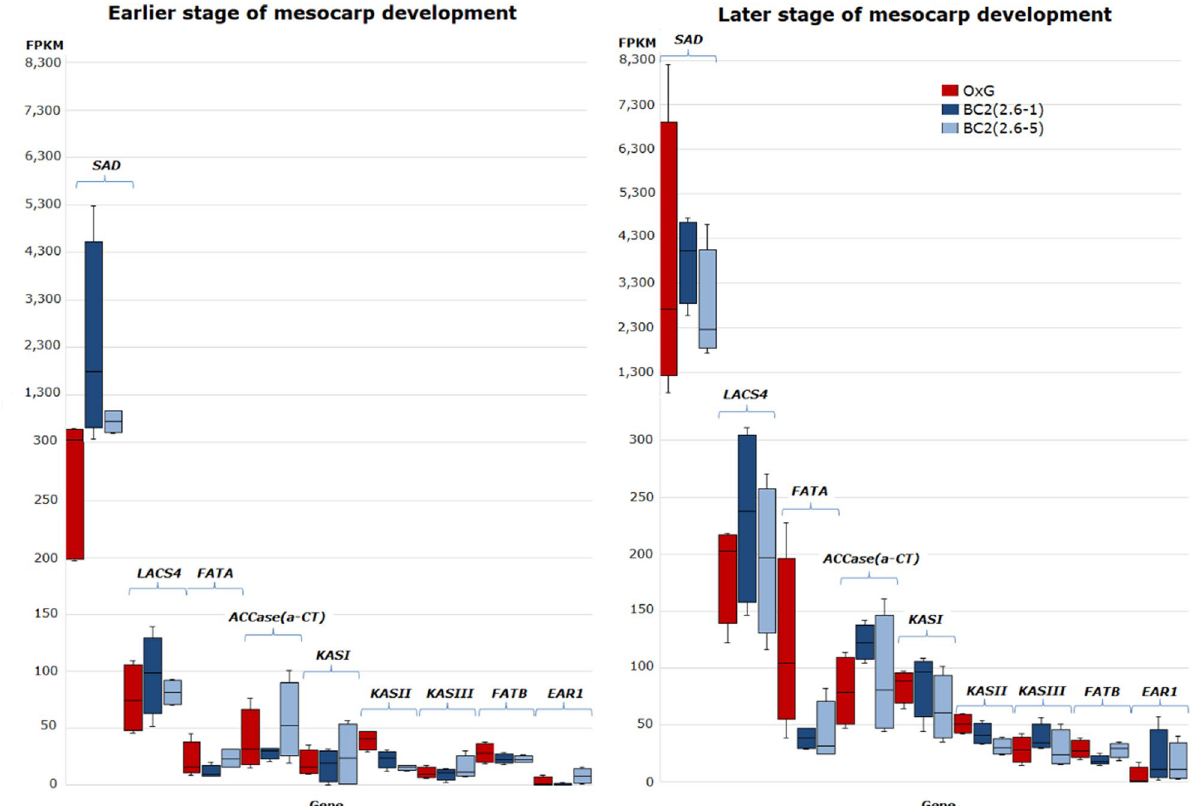
Figure 2. FPKM expression levels for various genes mapped to the fatty acid biosynthesis pathway as observed in the early (left panel) and late (right panel) stages of mesocarp